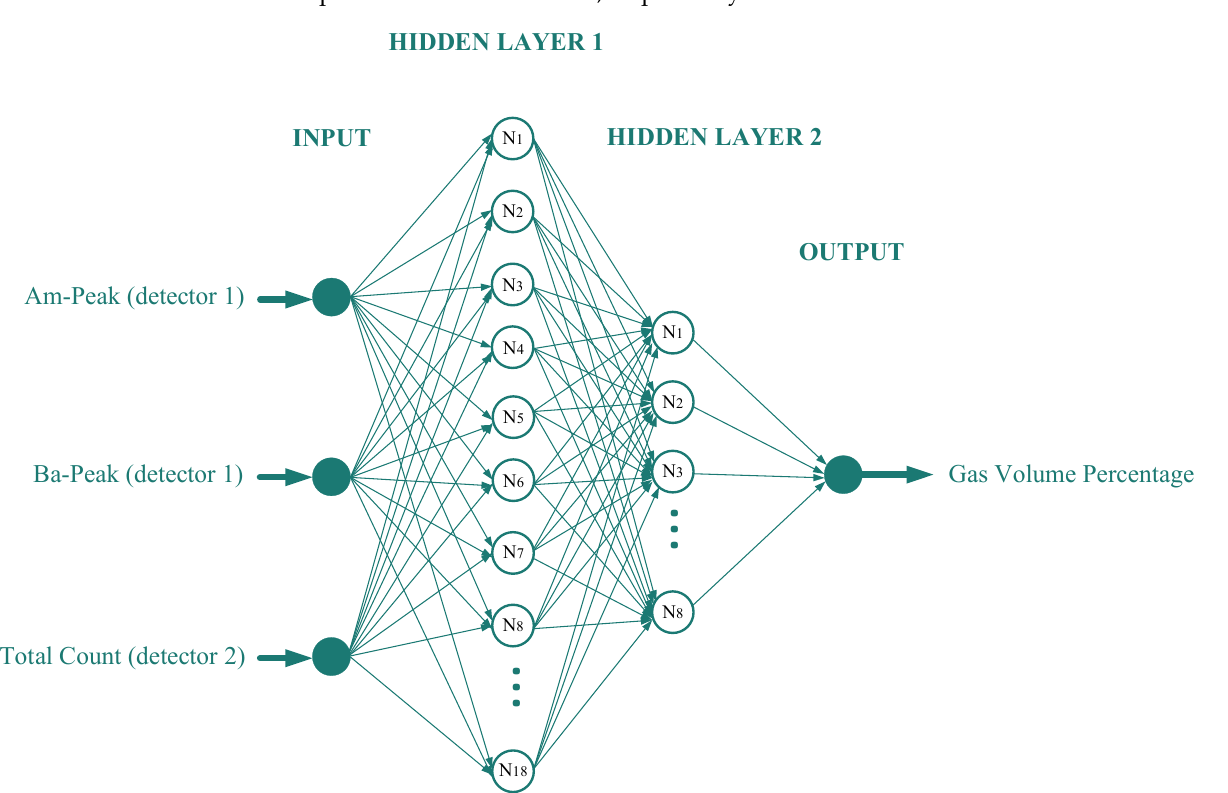
Figure 3. MLP Neural network for predicting gas volume percentage.